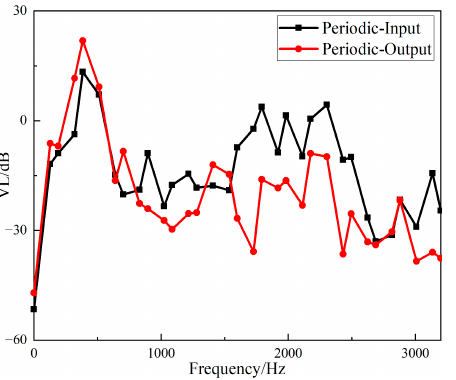
Figure 23. Frequency domain input and output VLz of the periodic structure support.